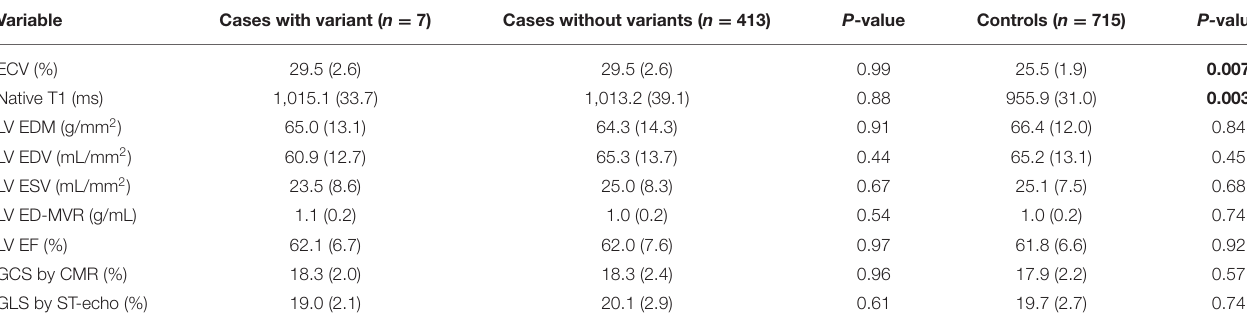
TABLE 4 | Comparison of LV anatomic features between cases with CM variants and without variants, as well as cases with CM variants and the controls.